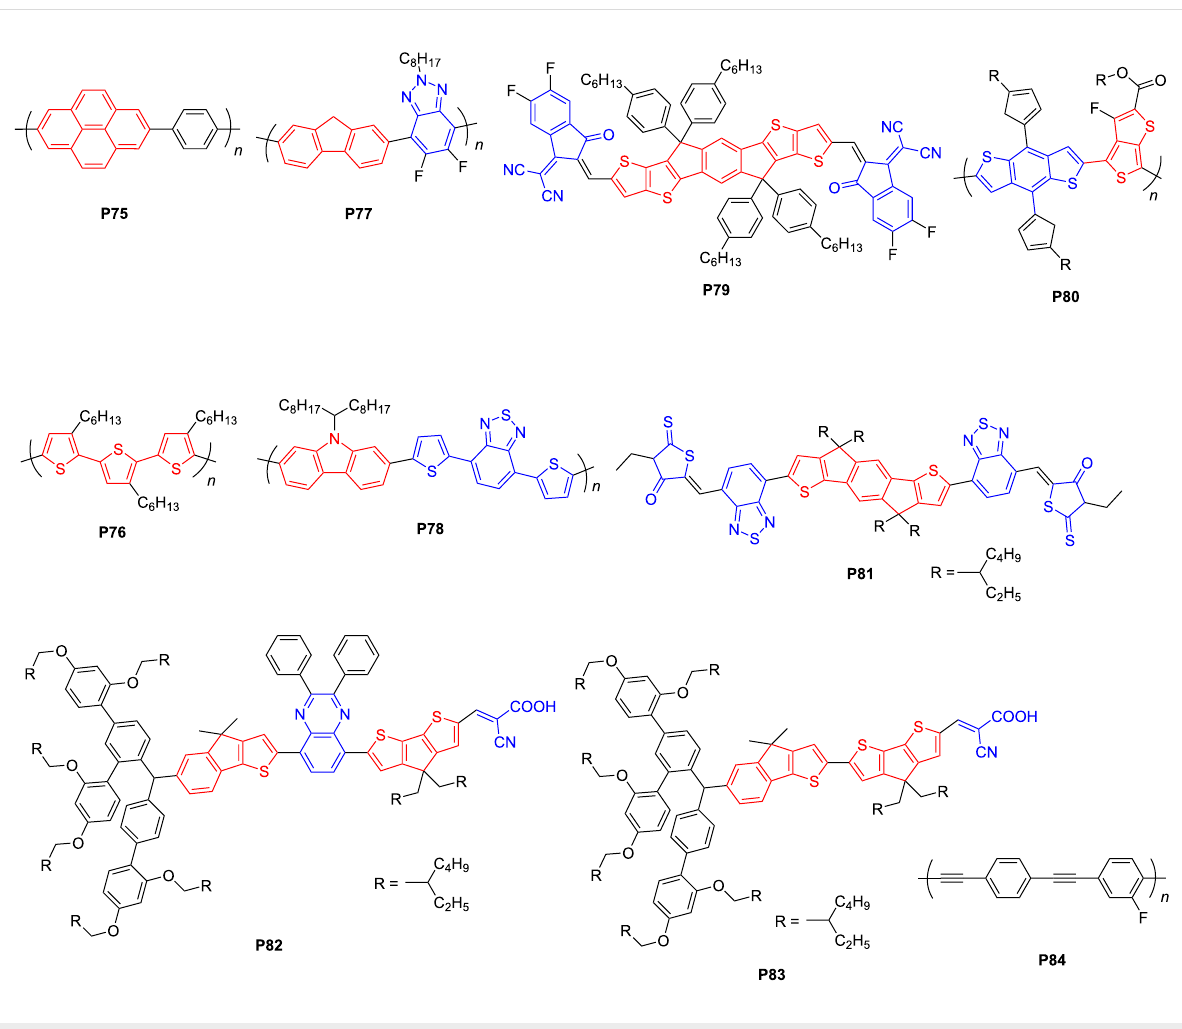
Figure 10: Schematic representation of structures of CPs for heterojunctions.